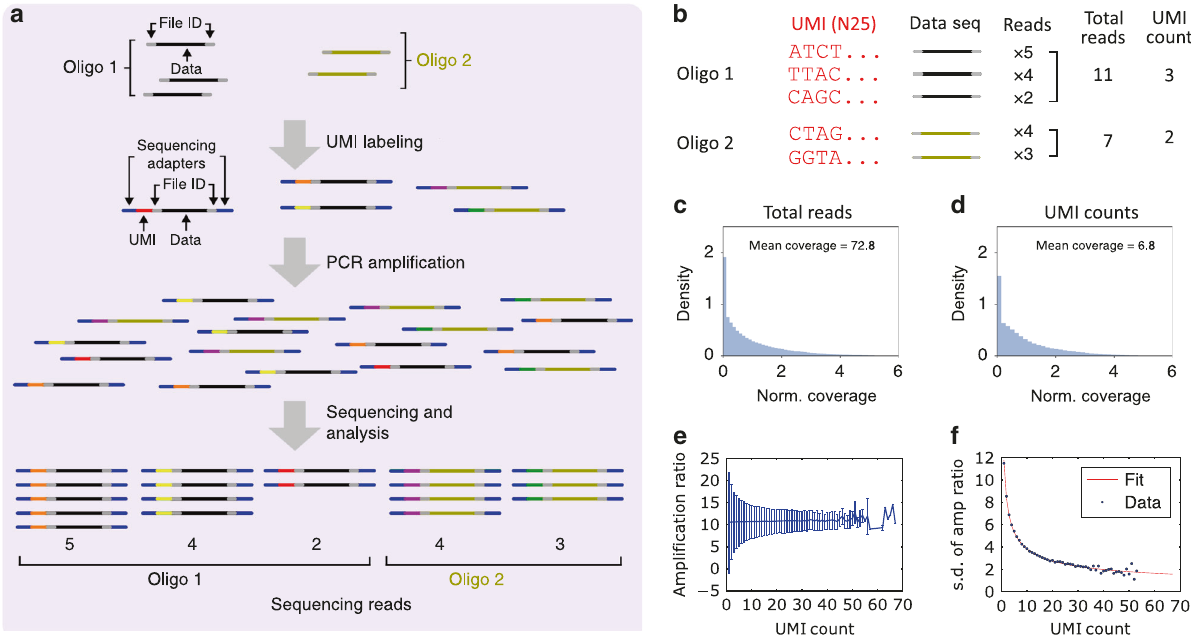
Fig. 2 Estimating oligonucleotide bias using unique molecule identi fi ers (UMIs). a Overview of tagging each single DNA molecule with UMIs. Each oligo sequence (e.g., represented in black, beige) in a pool has multiple copies and each copy is labeled with a UMI (represented in different colors) and universal Illumina sequencing adapters (represented in gray). After UMI labeling, oligos are PCR-ampli fi ed and sequenced. b Hypothetical examples of UMI counting. The UMI count of each sequence is a proxy for the oligo copy number from DNA synthesis. The total number of reads containing the same UMI is a proxy for the number of copies of a DNA molecule created by PCR. c The distribution of number of reads for each sequence, normalized to 83.0 mean coverage. Read counts are normalized to form a probability density (y-axis); the integral of the probability density is 1 (see “ Methods ” section). d The distribution of UMI counts for each sequence, normalized to 7.7 mean coverage. The biased UMI count distribution indicates that pools are already biased immediately after DNA synthesis, before any PCR is performed. e Ampli fi cation ratio versus UMI count. The average ampli fi cation ratio is roughly constant across UMI counts, but oligos with low initial copy numbers show higher variation. The error bars indicate standard deviation (s.d.) of ampli fi cation ratio. f Standard deviation (s.d.) of ampli fi cation ratio versus UMI count. The experimental data agree with Eq. (1). The number of unique sequences (sample size) is 457,772. Source data are available in the Source Data fi